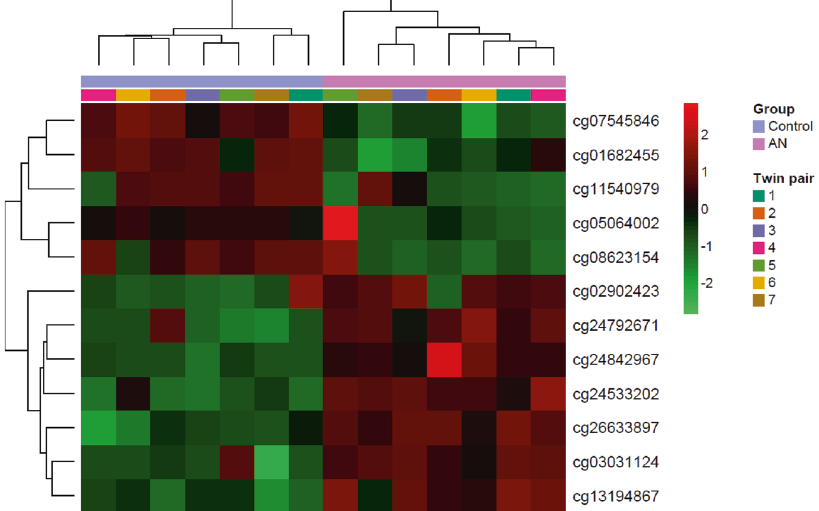
Fig. 3 Identi fi cation of a DNA-methylation signature characterising the differences between AN and control twins. Heatmap with the methylation status of the differentiating CpGs between AN and control twins. Rows (CpGs) and columns (individuals) are ordered according to the results of a hierarchical clustering algorithm. Z -score colour scale ranges from green for lower methylation to red for higher methylation